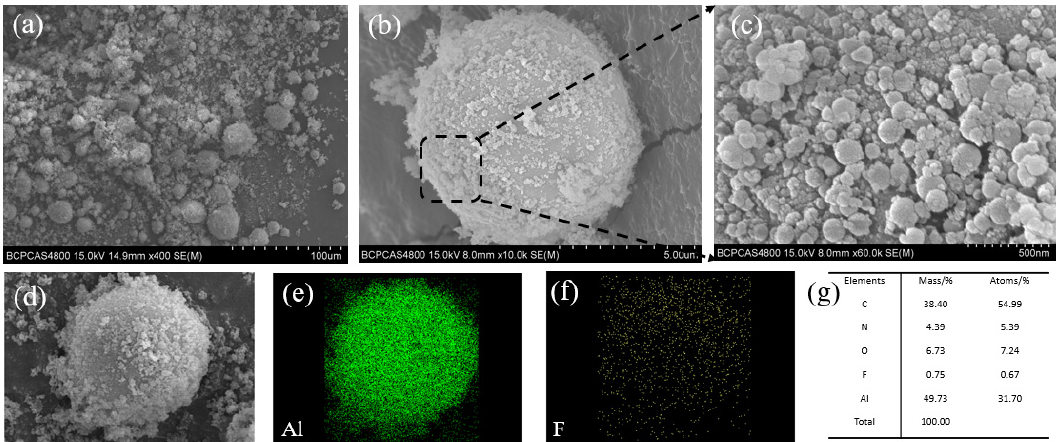
Figure 2. SEM and EDS of the micro-nano composite aluminum powder, micro structure from ( a – d ), and element distribution from ( e – g ).